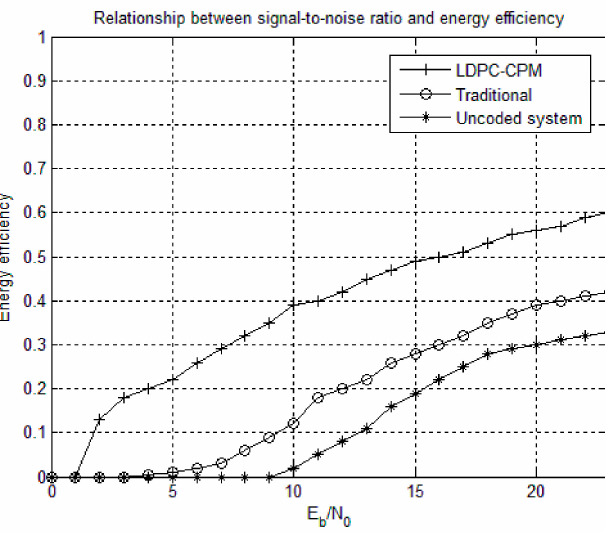
Figure 14. The relationship between signal-to-noise ratio (SNR) ratio and energy efficiency.